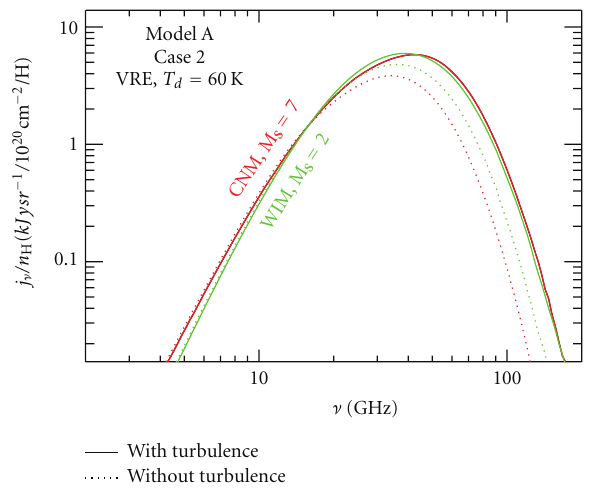
Figure 6: Spinning dust emissivity per H in the presence of compressible turbulence with sonic Mach number M s = 2 and 7, compared to that from uniform medium with n H = n H for the CNM (red) and WIM (green). The peak emissivity is increased, and the spectrum is shifted to higher frequency due to compressible turbulence. Case 2 ( μ 1 = 0) of µ orientation is considered. Figure reproduced from Hoang et al.